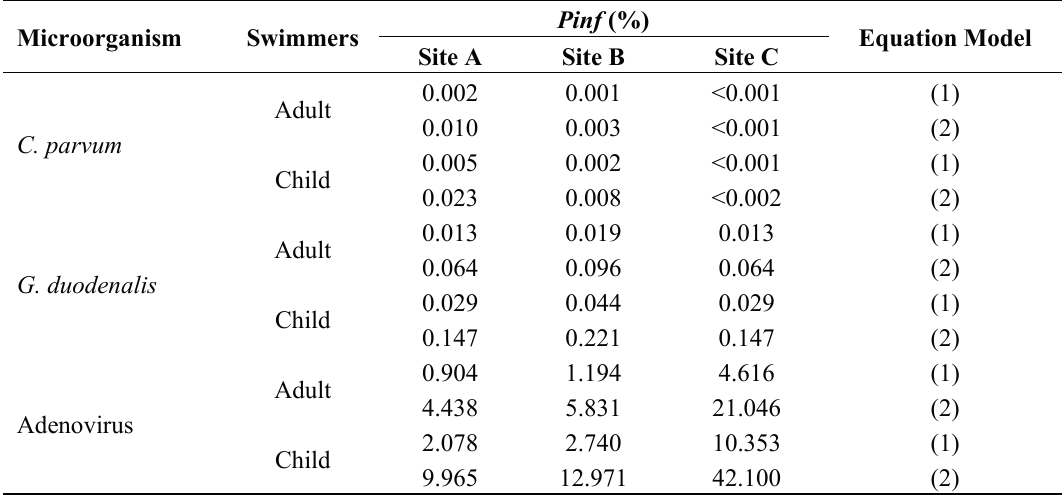
Table 3. Calculation of the probability of becoming infected ( P inf ) during summer for three waterborne pathogens detected in river